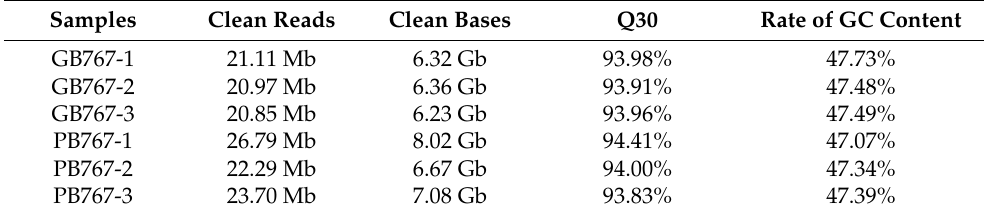
Table 1. Summary of the transcriptome sequencing data quality of six samples.